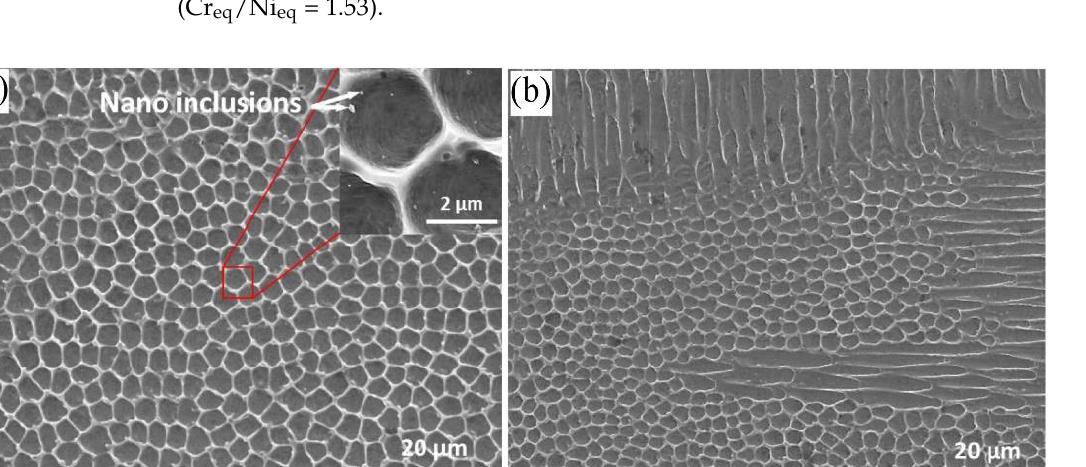
Figure 10. Microstructure of the 316 L stainless steel samples produced using ( a ) the laser ingineered net shaping technique and ( b ) X-ray diffraction patterns of the 316 L stainless steel powder, and ( c ) sample obtained using the LENS technique. Reprinted with permission from [60], Copyright 2016 Elsevier.